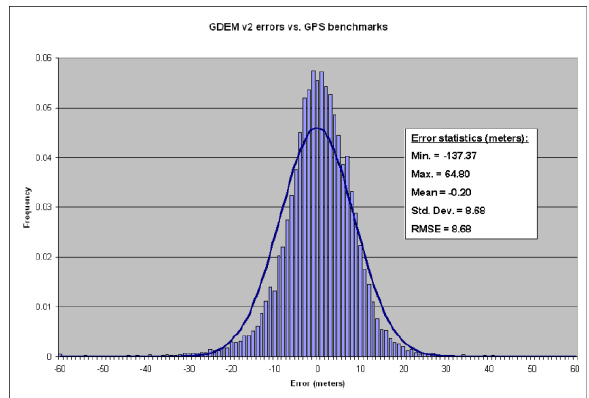
Figure 3. GDEM v2 absolute vertical accuracy.